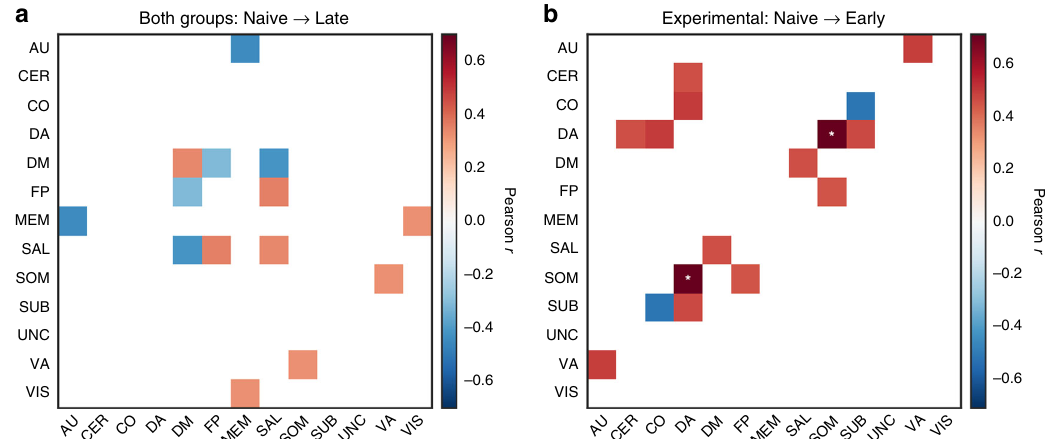
Fig. 7 Relationship between the change in network dynamics and the change in behavior. Colored tiles represent all signi fi cant correlations ( p < 0.05, uncorrected; * p < 0.05 FDR-corrected). a Pearson correlation coef fi cient ( r ) between the across-session changes in recruitment (or integration) and the across-session changes in d 0 ( Δ d 0 ) observed for both the experimental and control groups. b Relationship between the changes in recruitment (or integration) and the changes in d 0 during early phase of training of the experimental group. AU: auditory, CER: cerebellum, CO: cingulo-opercular, DM: default mode, DA: dorsal attention, FP: frontoparietal, MEM: memory, SAL: salience, SOM: somatomotor, SUB: subcortical, UNC: uncertain, VA: ventral attention, VIS: visual. Source data are provided as a Source Data fi